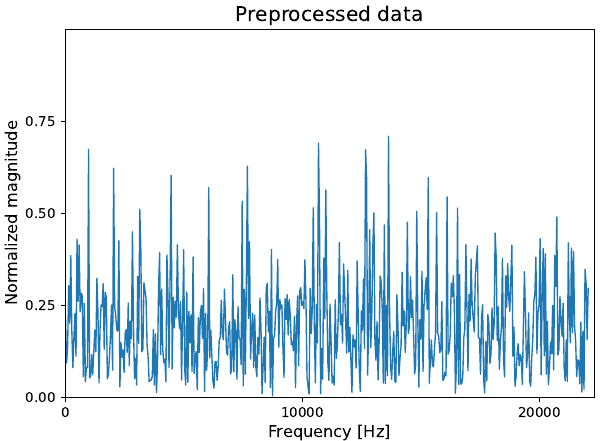
Figure 7. An example showingthe common preprocessing results of the of raw data. The sample is transformed by fast Fourier transformation from the time domain to the frequency domain, then normalized to a range between 0 and 1.